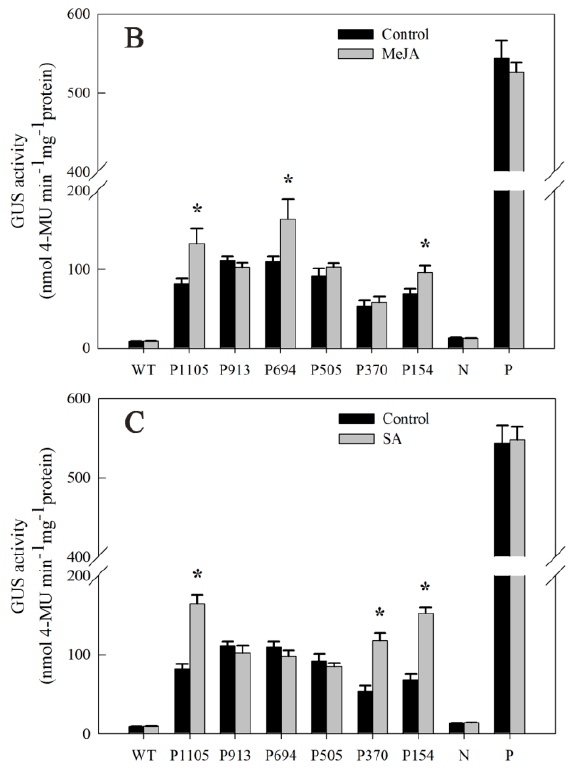
Figure 8. Analysis of GUS activity from promoters in response to hormonal treatments in transiently transformed tobacco leaves. ( A ) Sprayed with 189 µM ABA; ( B ) Sprayed with 100 µM MeJA; ( C ) Sprayed with 100 µM SA. Mean activity was averaged from three independent experiments. Vertical bars represent the standard errors of means. Stars (*) represent significant differences according to the LSD test ( p < 0.05).